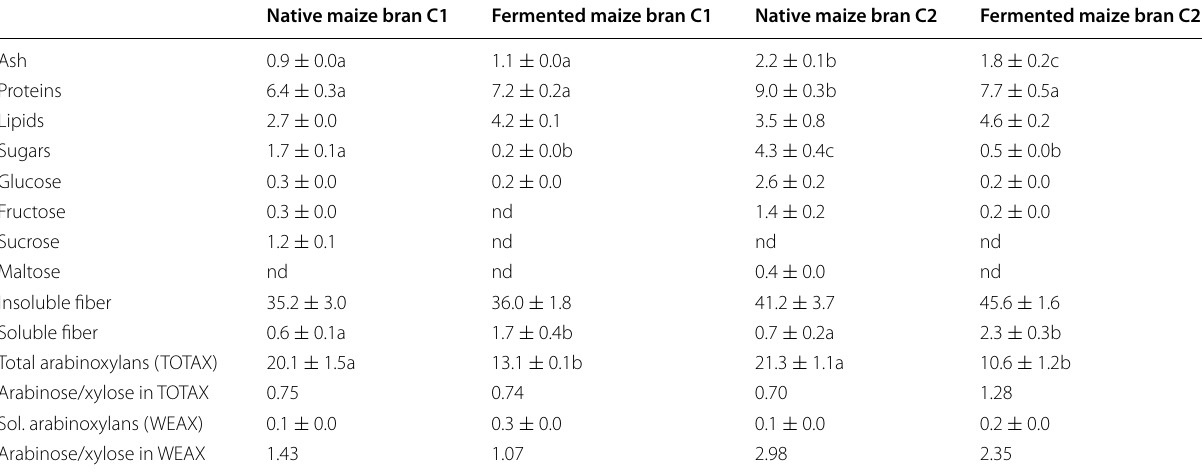
Table 4 Chemical composition (mean brans